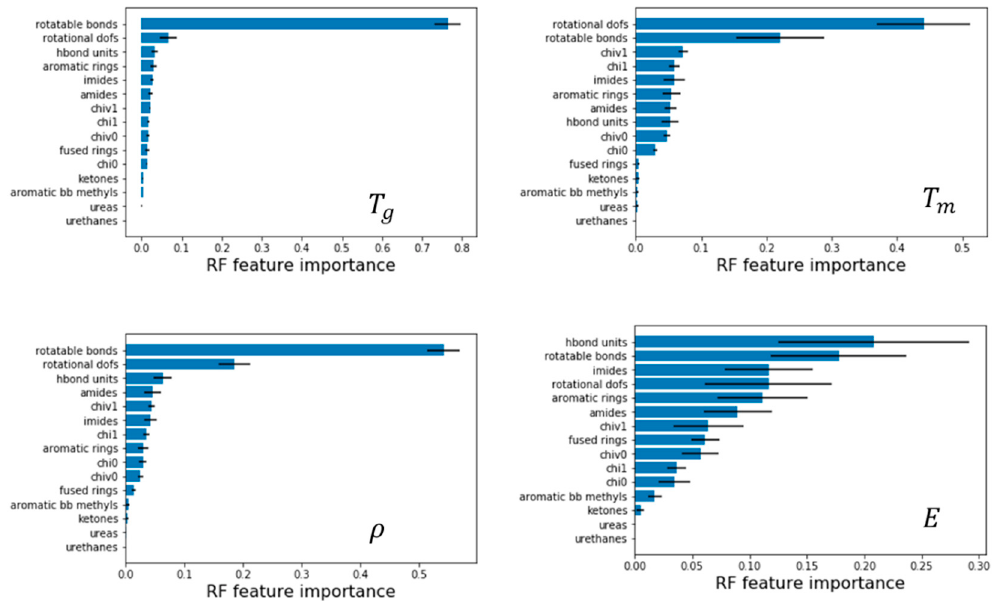
Figure 7. Feature importance of QSPR descriptors for models of T g , T m , ρ , and E calculated from RF models using normalized QSPR descriptors with CI as input.